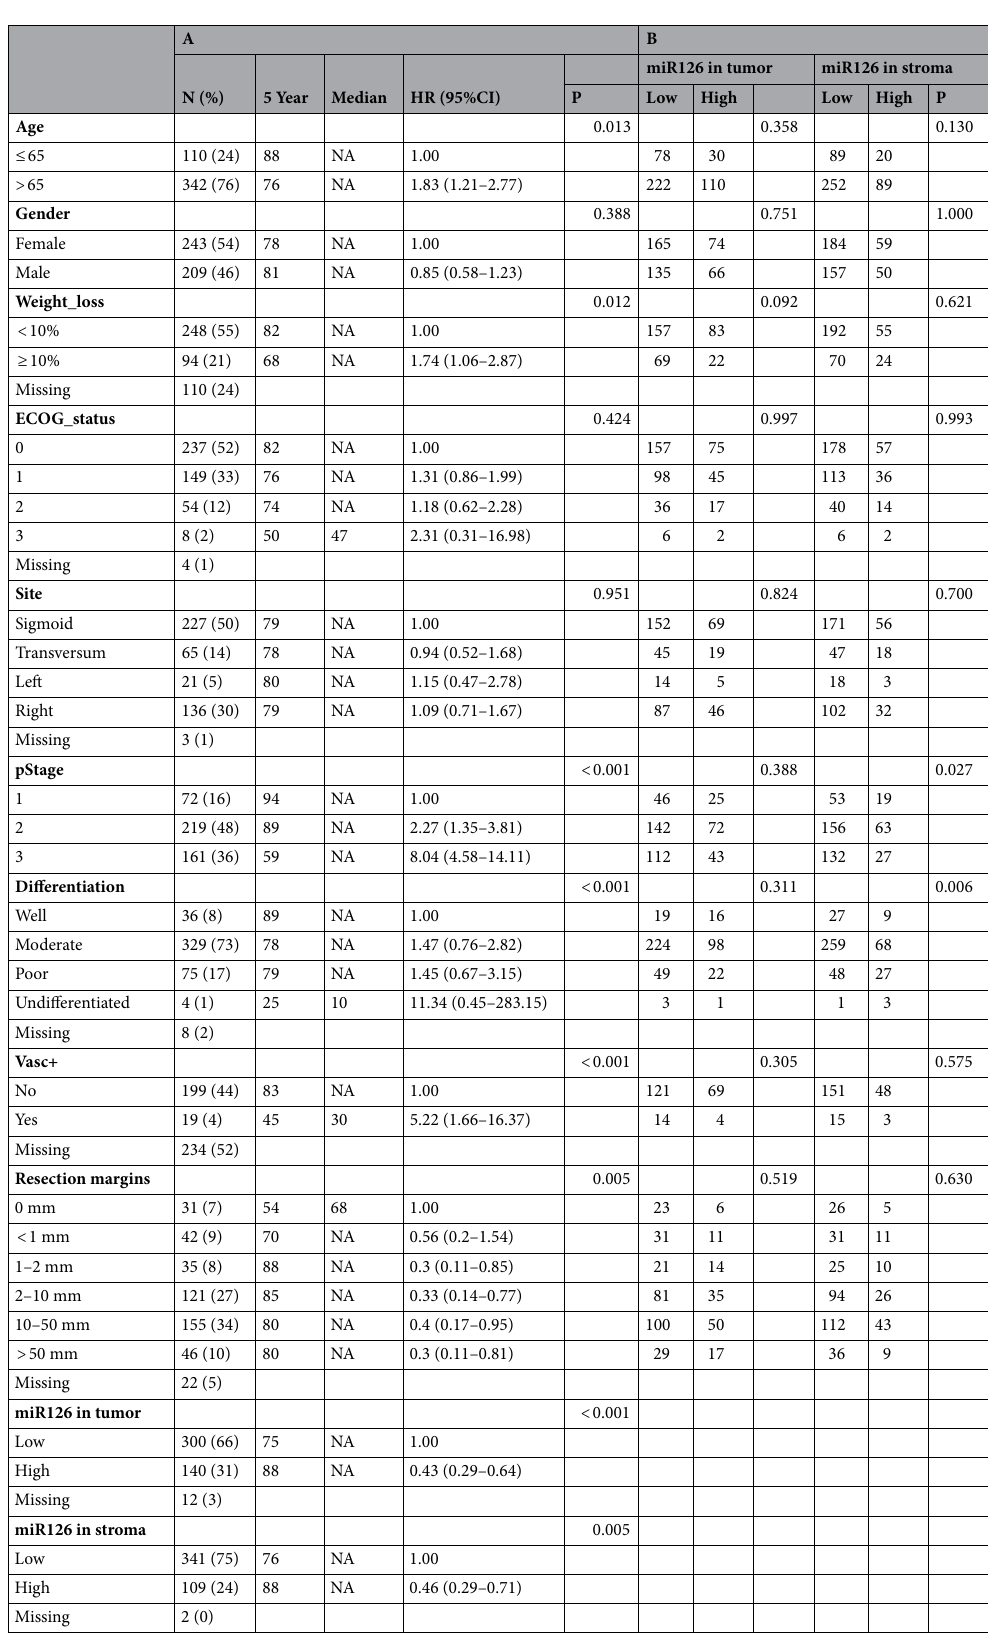
Table 2. (A) Clinicopathological variables and miR-126 in tumor and stroma as predictors of disease-specific survival for colon cancer patients (univariate analyses, log-rank test, n = 452), (B) dichotomized miR-126 in tumor and stroma and their distribution over and correlation with clinicopathological variables (chi-square and Fisher’s exact tests). ECOG, eastern cooperative oncology